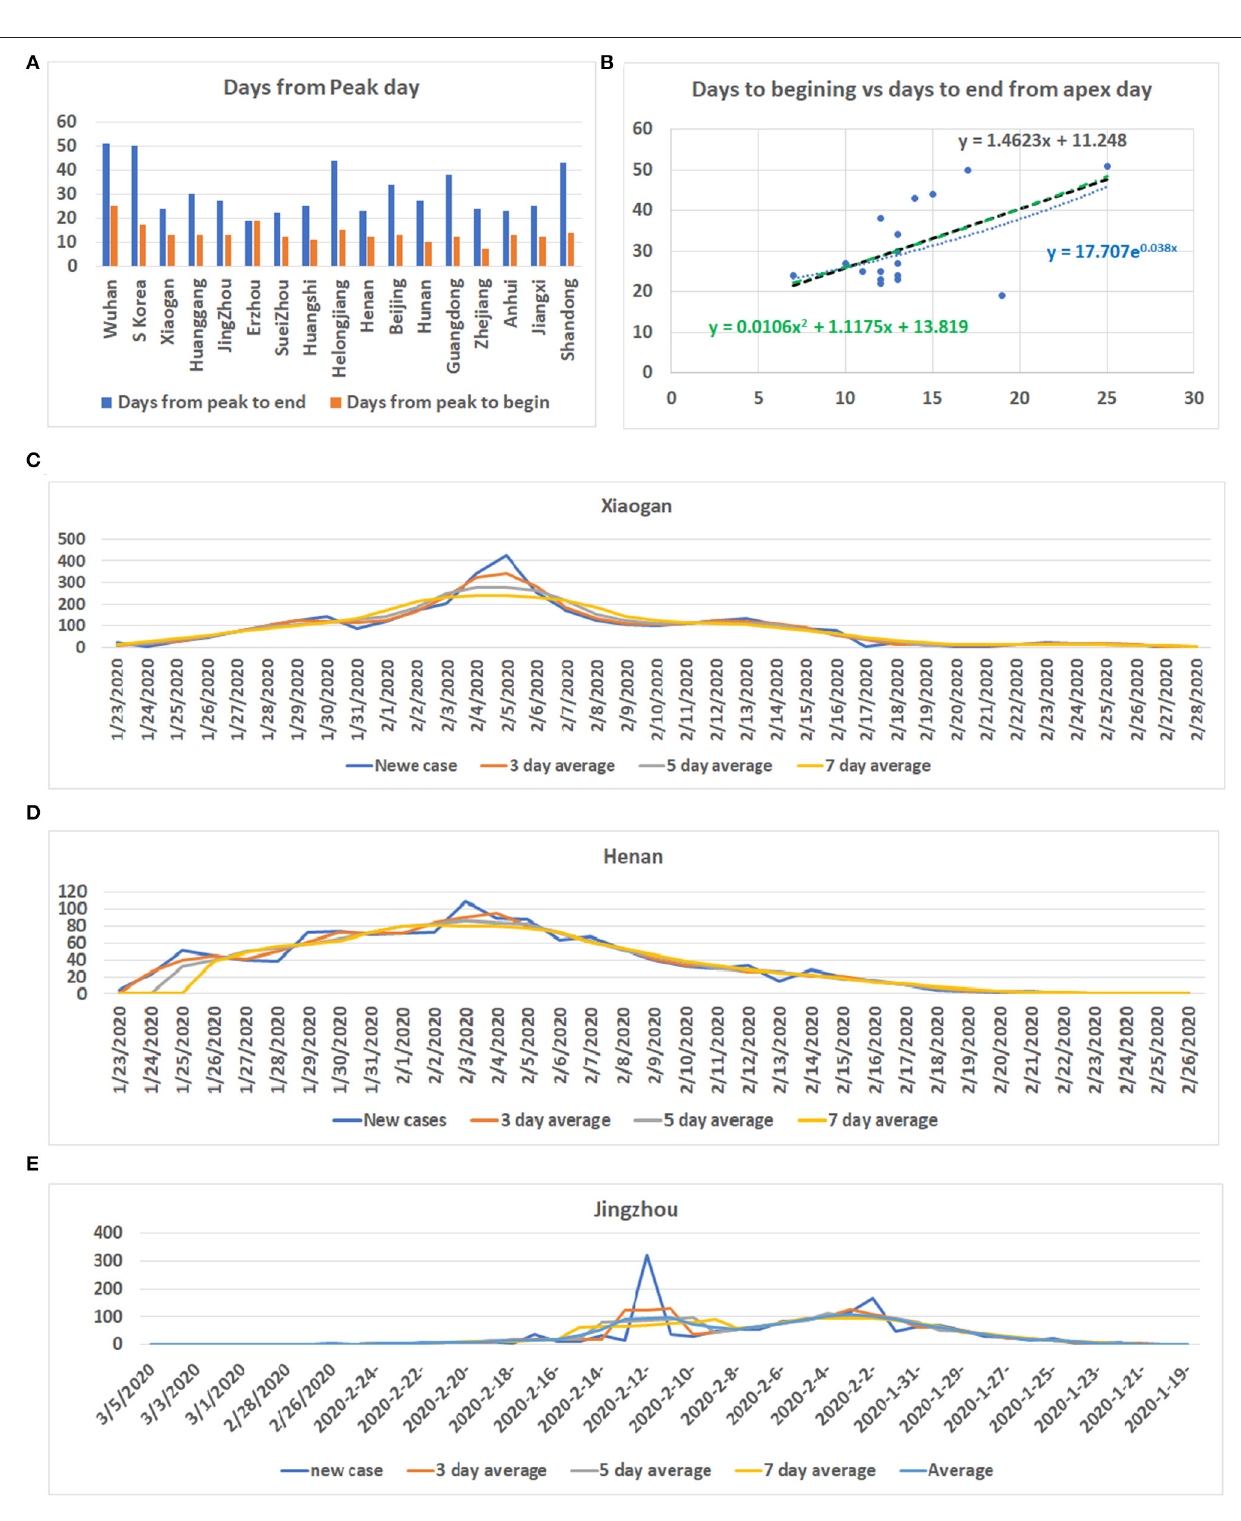
Frontiers in Medicine |